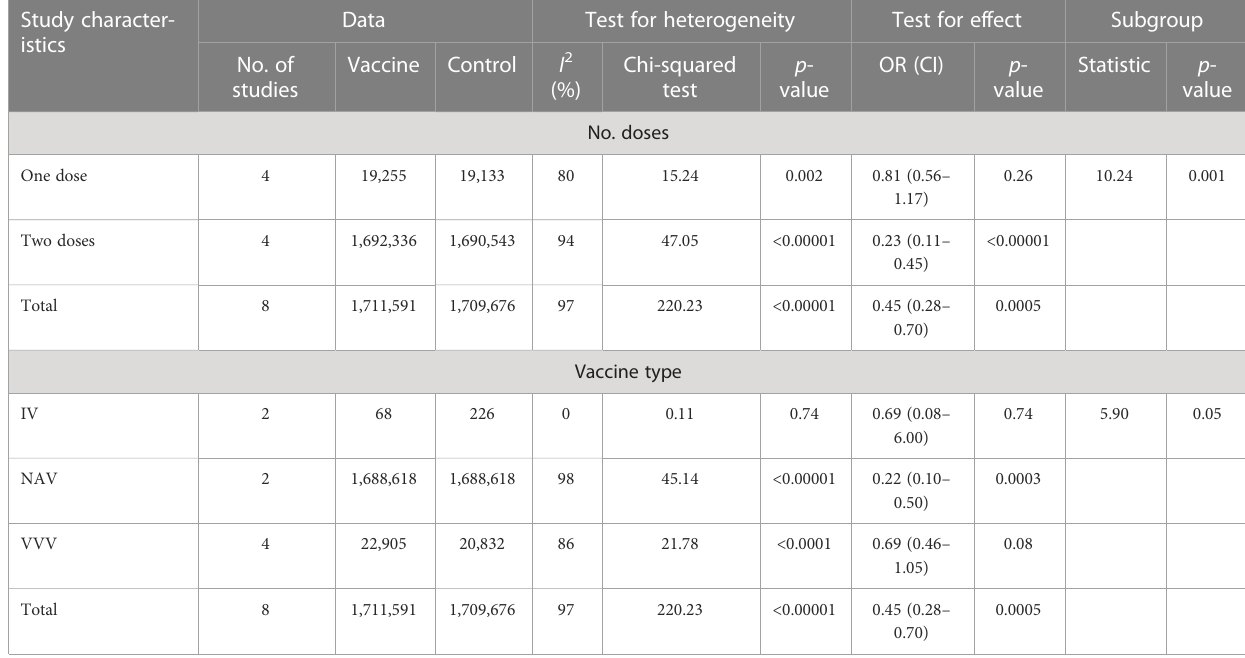
TABLE 2 Subgroup analysis for vaccine effectiveness.